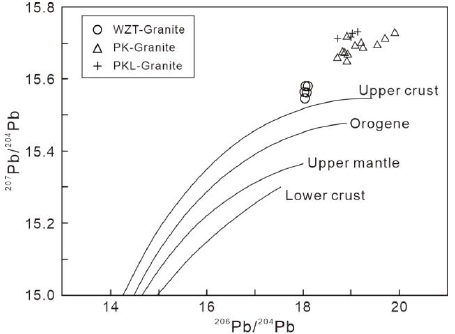
Figure 10. Plot of 206 Pb/ 204 Pb vs. 208 Pb/ 204 Pb (after [76]) of the Wuzhutang granite from the Xuebaoding mining area, Sichuan Province, China. Data of the Pankou and Pukouling granites are from